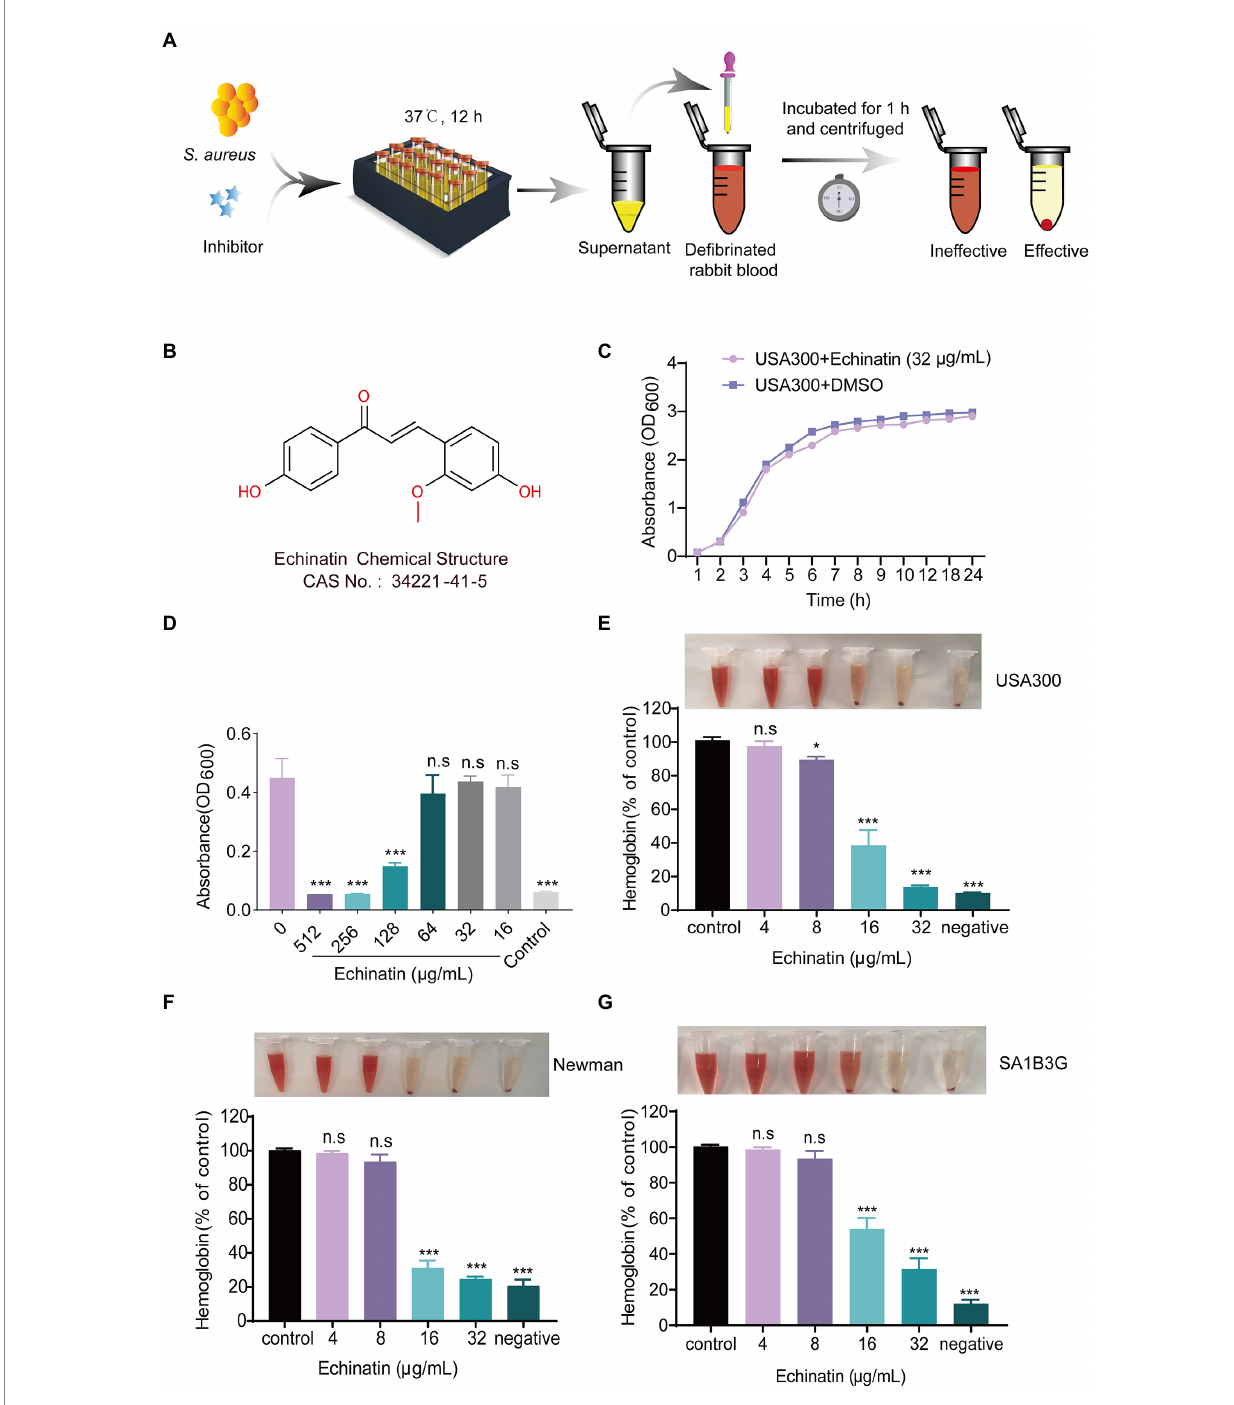
FIGURE 1 Echinatin inhibits the hemolysis of Staphylococcus aureus without affecting bacterial growth. (A) In vitro manual screening system for Hla inhibitors of S. aureus based on defibrinated rabbit blood. (B) Chemical structure of echinatin. (C) Growth rate of S. aureus USA300 grown in TSB at 37 ° C with 32 μ g/ mL echinatin or DMSO. (D) The bacterial inhibitory ability was determined by the MIC of echinatin against USA300 by the microbroth dilution method. (E–G) The effects of echinatin on the hemolytic activity of S. aureus USA300, Newman, and SA1B3G in vitro . Triton X-100 was used as a negative control. Data are presented as the mean ± SD, and the experiments were performed in triplicate. * p < 0.05, ** p < 0.05, and *** p <